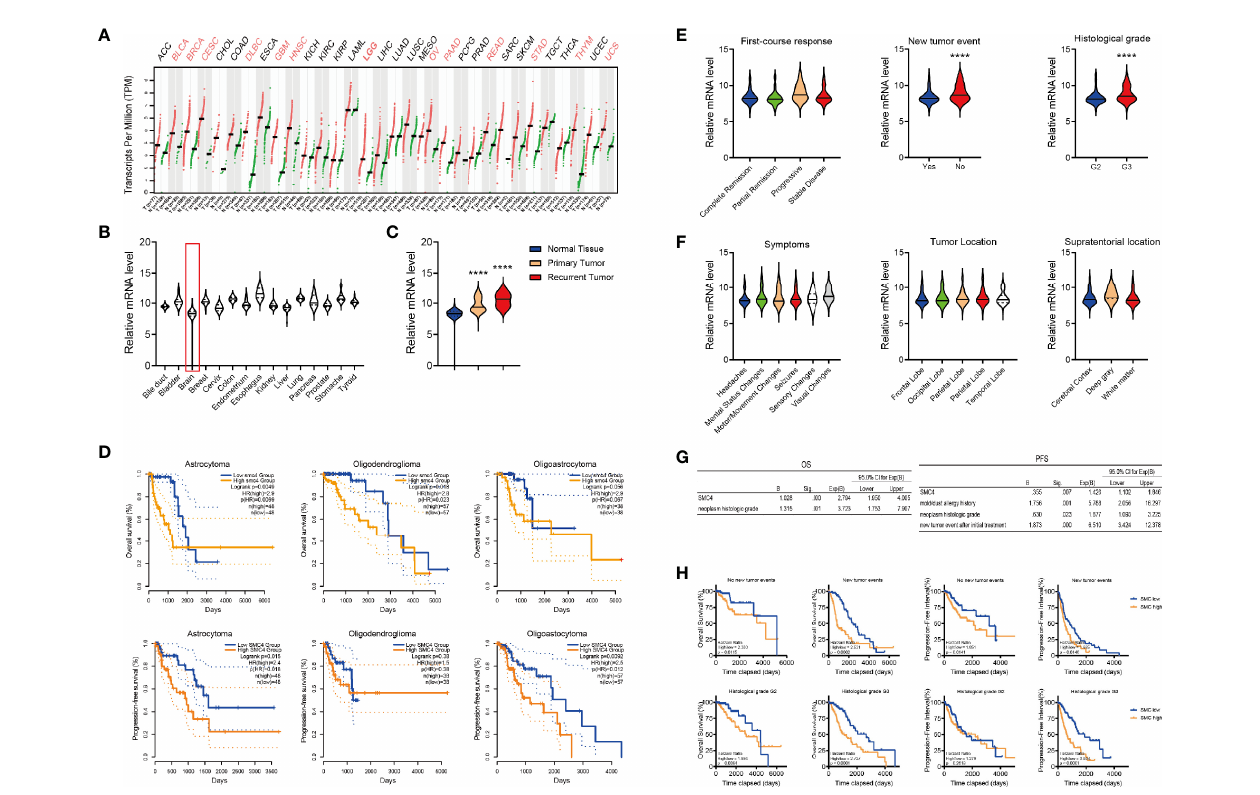
FIGURE 3 | The expression of SMC4 in glioma patients. (A) The expression of SMC4 in 32 different cancer types in the GEPIA database. (B, C) The expression of SMC4 in normal tissues (B) or primary/recurrent tumor tissues (C) from the GTEX database. (D) Kaplan-Meier analysis comparing the OS and PFI in glioma patients with different histologic origins (n = 97, 75 and 114 for astrocytoma, oligoastrocytoma and oligodendroglioma respectively). Patients were divided into two groups according to SMC4 expression level. (E) Violin plot showing the expression of SMC4 in glioma patients with the different fi rst-course responses (the left panel), new tumor events (the middle panel), or histologic staging (the right panel). (F) Violin plot showing the expression of SMC4 in glioma patients with different symptoms (the left panel), tumor location (the middle panel), or supratentorial location (the right panel). (G) Tables showing the results from the multivariate Cox Regression model for the OS (the left panel) or the PFI (the right panel) with SMC4 and different clinical features in LGG patients. (H) Kaplan-Meier analysis comparing the OS and PFI of SMC4 high or low-expressing LGG patients, with or without new tumor events (the top panel) or patients from different histologic staging (the bottom panel). OS, Overall Survival; PFI, Progression-Free Interval; LGG, lower-grade glioma. ****p <